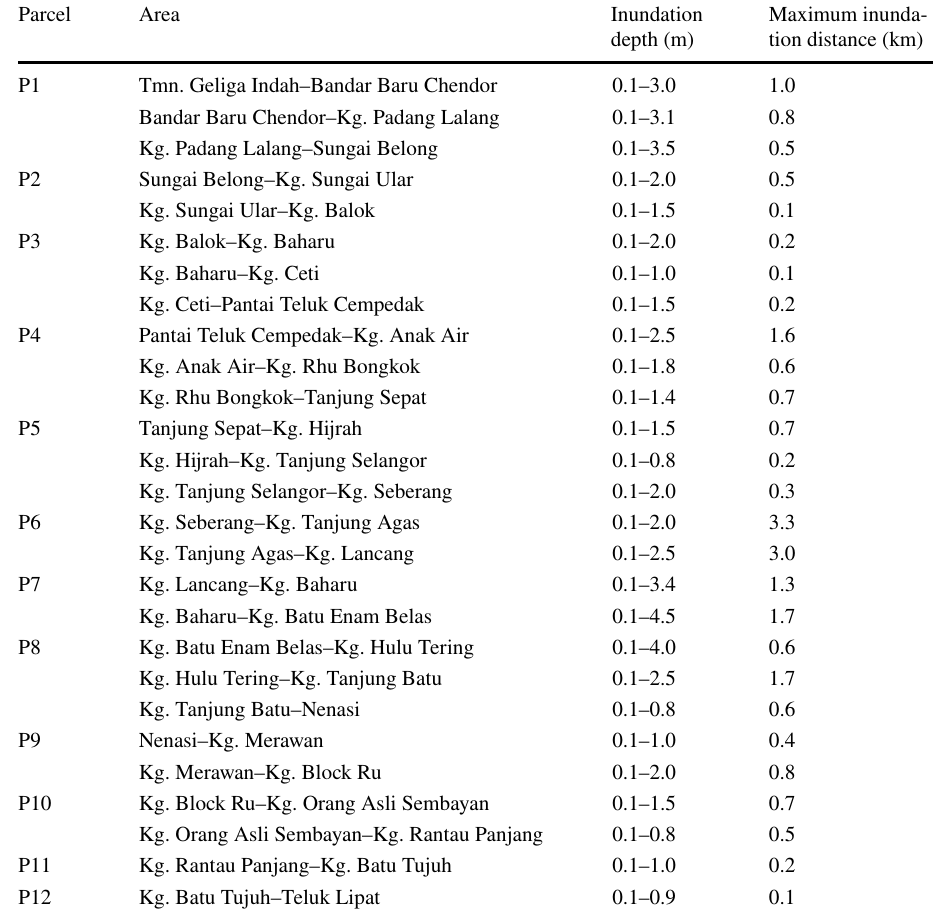
Table 6 Inundation depths and inundation distances in Pahang at Mw